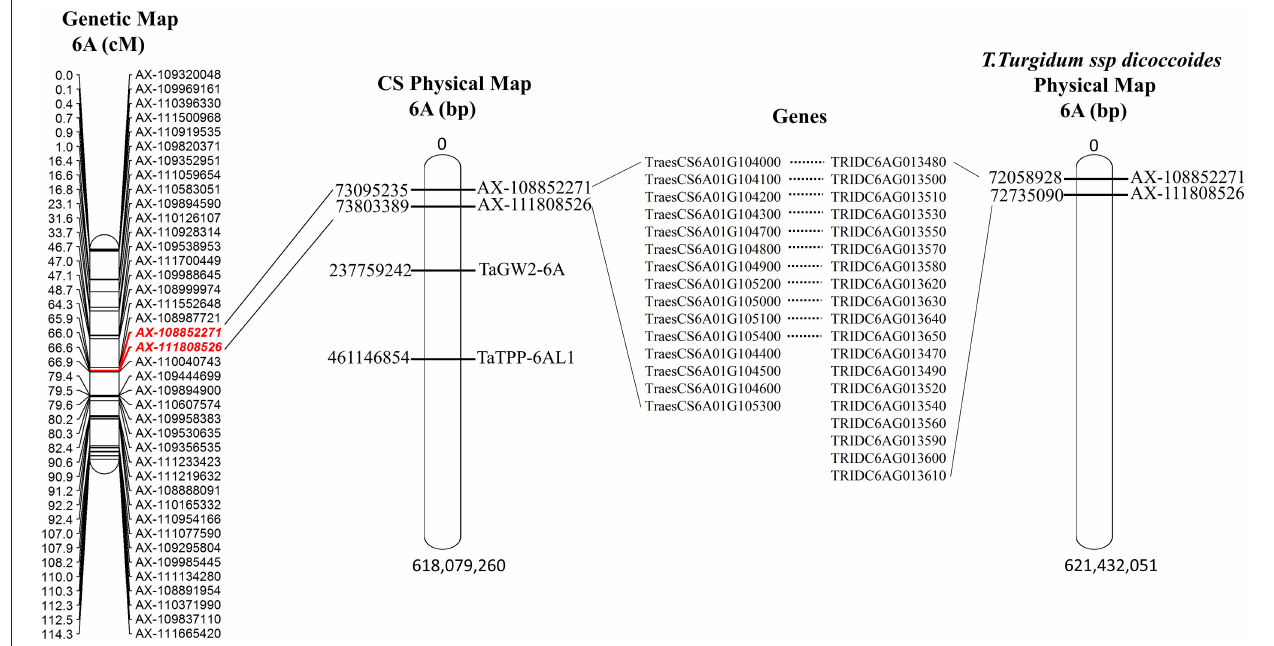
FIGURE 7 | The physical position for QKa.sau-6A.2 and its comparison with previous reported QTLs for kernel size. The two flanking molecular markers of QKa.sau-6A.2 ( AX-108852271 and AX111808526 ) were located at 73.09–73.80Mb of the physical map of the Chinese Spring genome reference sequence (73095235, 73803389) and 72.06–72.74Mb of the physical map of the T. Turgidum ssp. dicoccoides genome reference sequence (72058928, 72735090). A total of 15 or 19 genes were included in this region in Chinese Spring and T. Turgidum ssp. dicoccoides, respectively.